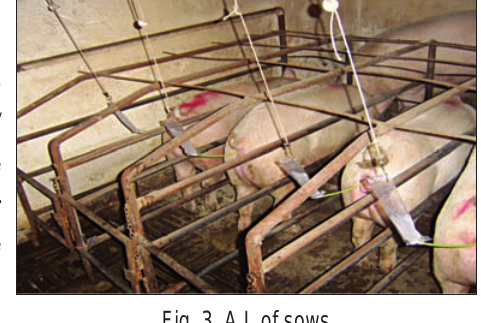
Fig. 3. A.I. of sows